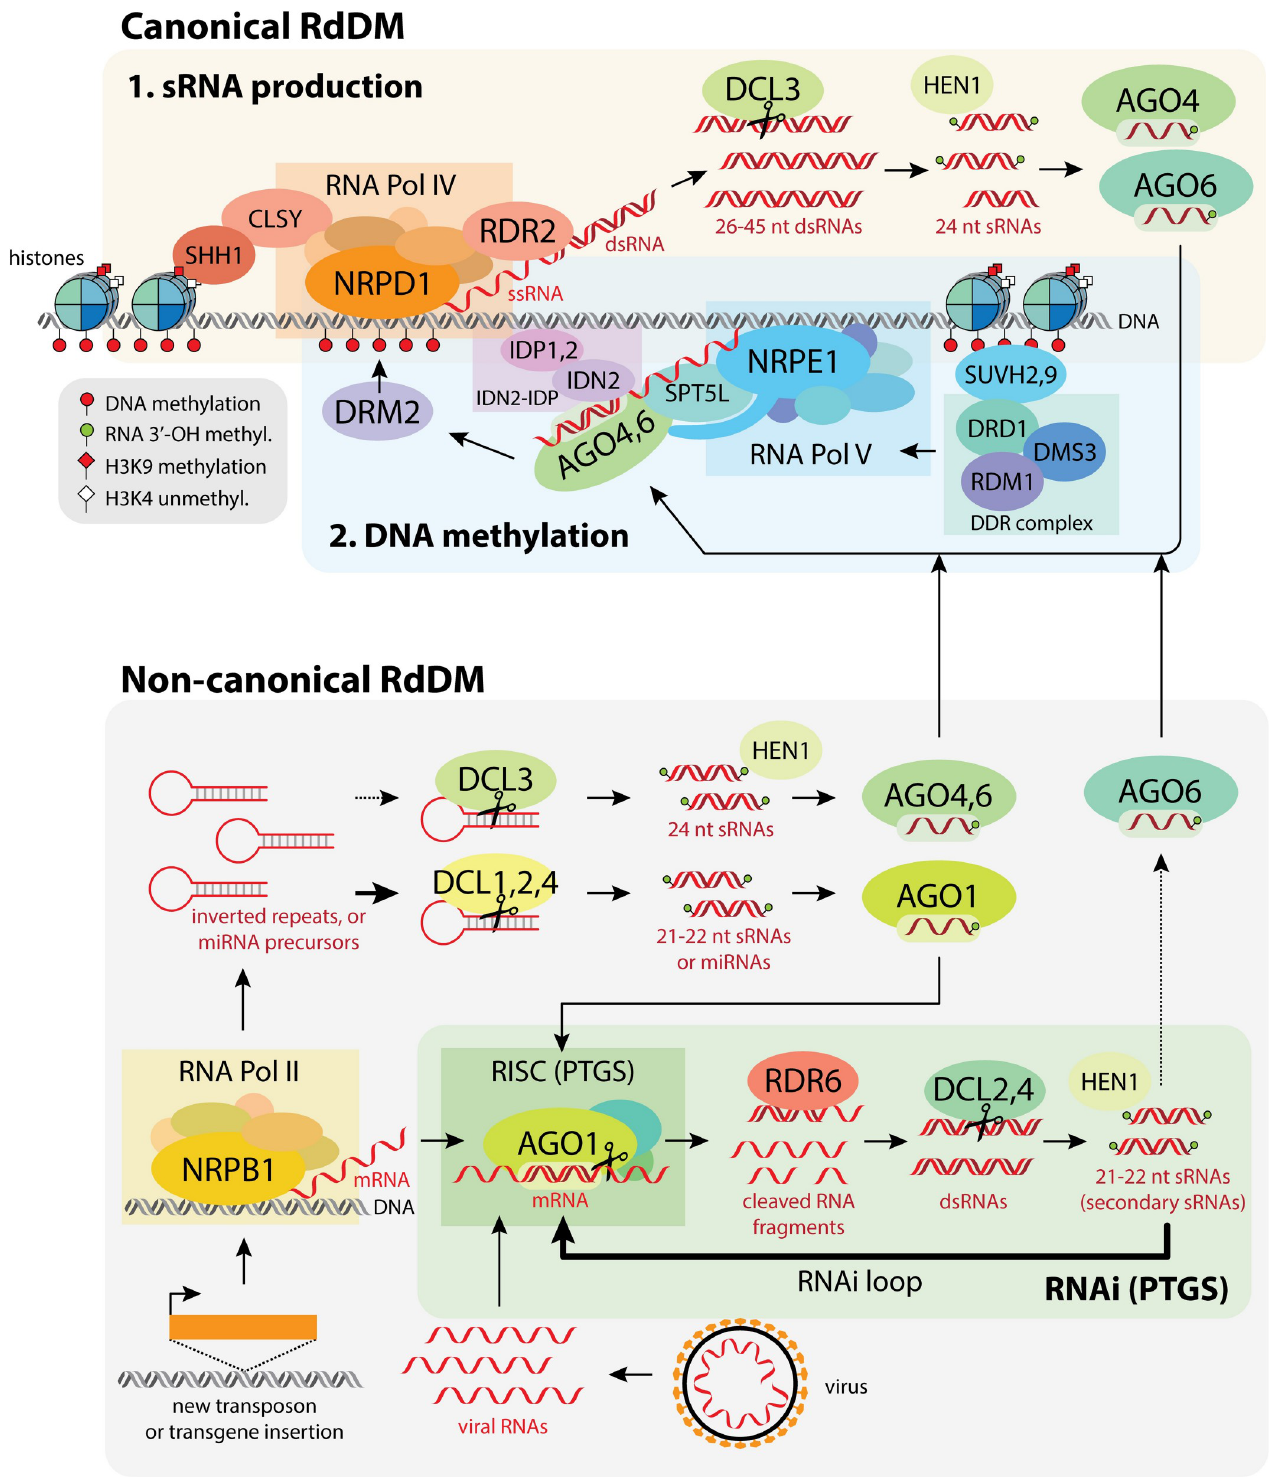
Fig 3. Schematic of the canonical RdDM pathway (top), and non-canonical RdDM and RNAi/PTGS (bottom). The canonical RdDM pathway can be broken into (1) sRNA production and (2) targeting DNA methylation to sites of sRNA production. The non-canonical RdDM pathway is closely related to RNAi and other PTGS pathways, and differs from canonical RdDM primarily in the source of sRNAs and sRNA processing. H3K9 = lysine 9 on histone H3; H3K4 = lysine 4 on histone H3; ssRNA = single-stranded RNA; dsRNA = double-stranded RNA, miRNA = microRNA.